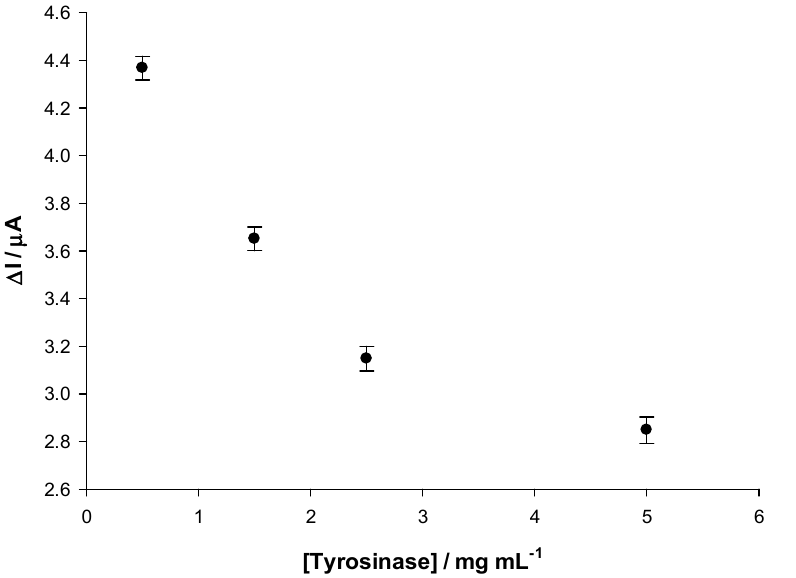
Figure 3. Effect of Tyr concentration on the cathodic peak current of the Tyr/ChitNPs/GPH/SPE in PBS (0.1 M, pH 7.2, KCl 0.1 M) with 50 μ M DA.